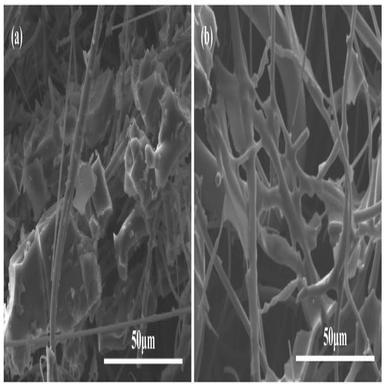
Microstructures of PFMs of before (a) and after sintered (b).